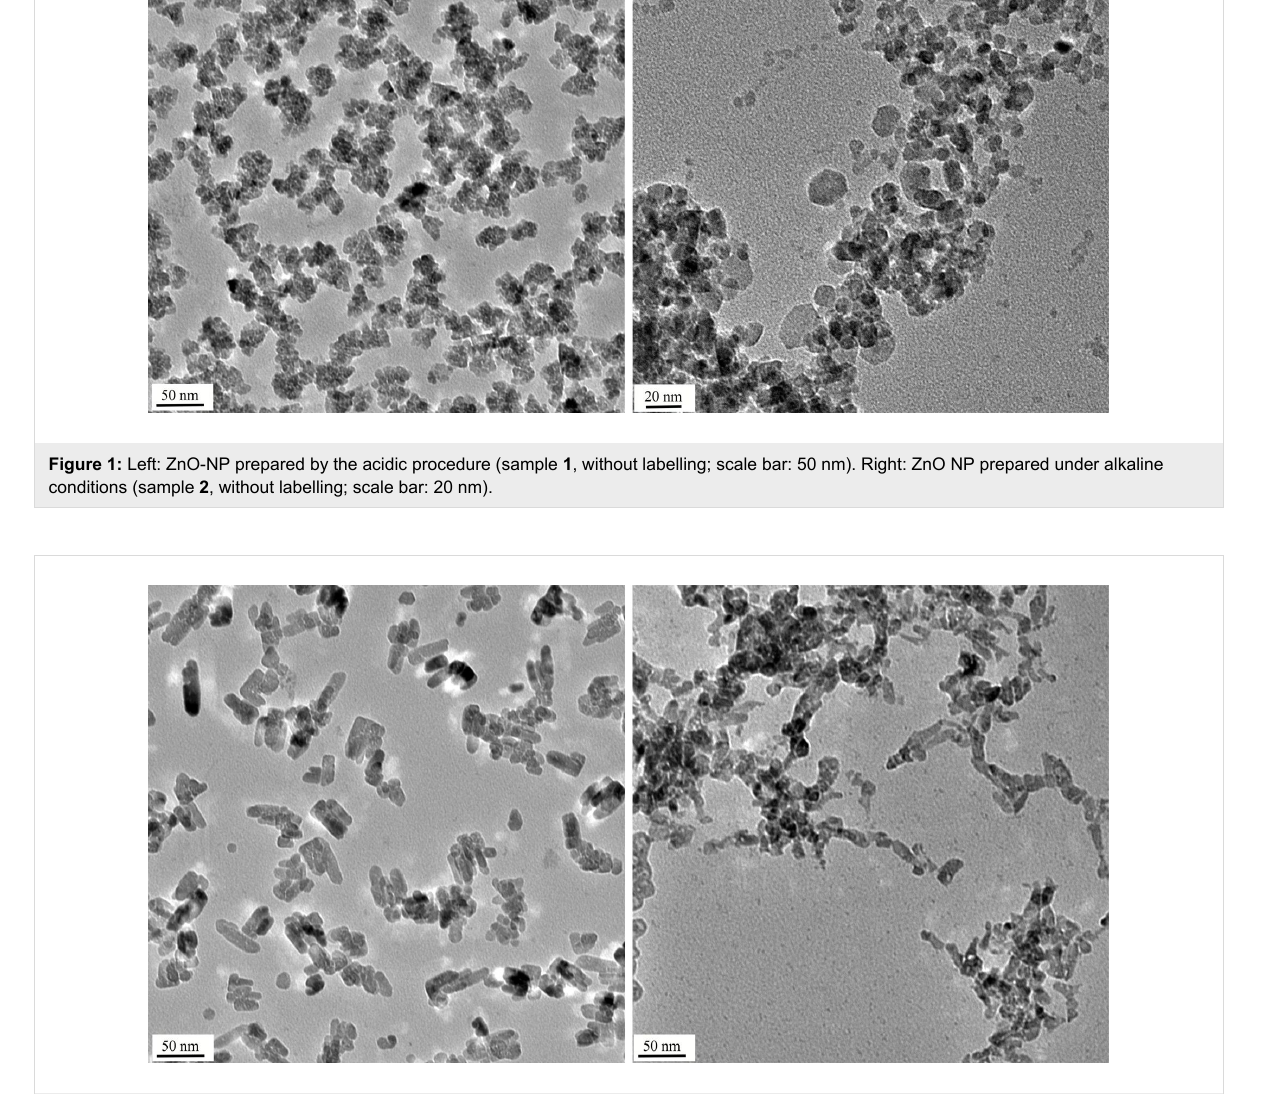
to remove any soluble phosphate. The solid was then redis- persed in ethanol and deposited on the copper grid for the subsequent TEM investigation. An aliquot was dissolved in acid and analyzed for the phophorus/zinc molar ratio by